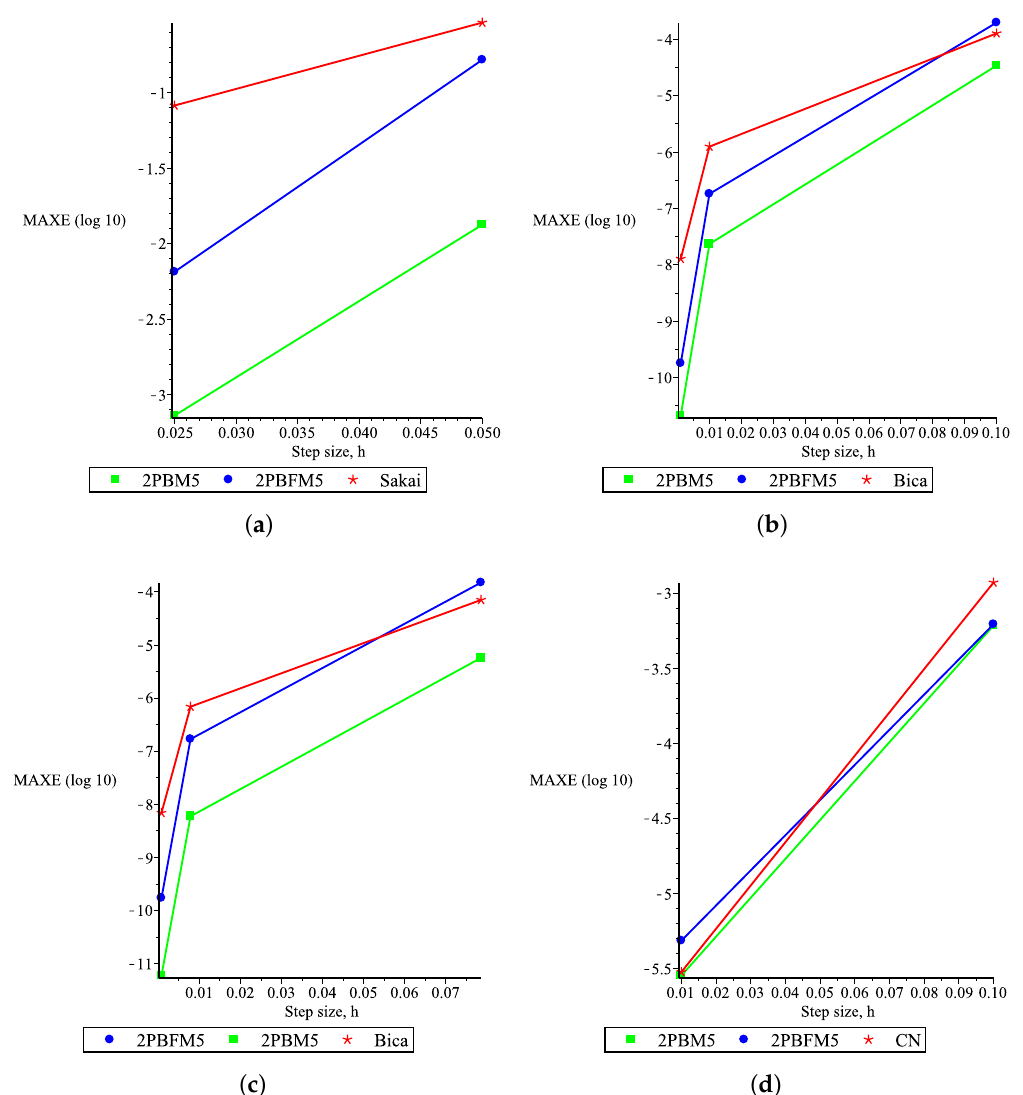
Figure 3. Graphs of log maximum absolute error (MAXE) against step size, h . ( a ) Problem 1, ( b ) Problem 2, ( c ) Problem 3, ( d ) Problem